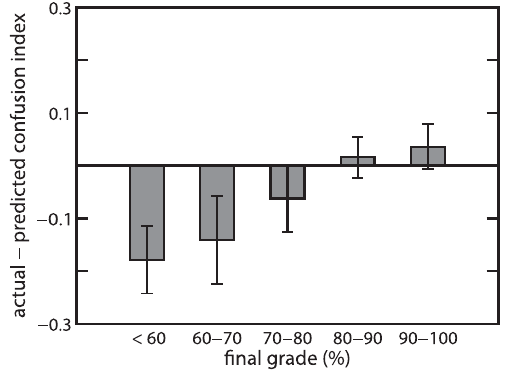
FIG. 3. Difference between each student ’ s average confusion index and the confusion index predicted by regression model 3 s (which includes the reading assignment correctness, confidence in reasoning, and self-efficacy during the spring semester), binned according to final grade. The vertical axis displays the difference in confusion index; although the absolute scale of confusion index ranges from 0 (not at all confused) to 2 (very confused), the difference between actual and predicted values can be positive or negative. The horizontal axis displays final grades binned roughly according to letter grade. The error bars represent the standard error of the mean of binned values. The numbers N of students in each bin are as follows: 60 or lower ( N ¼ 2 ), 60 – 70 ( N ¼ 3 ), 70 – 80 ( N ¼ 14 ), 80 – 90 ( N ¼ 41 ), and 90 –